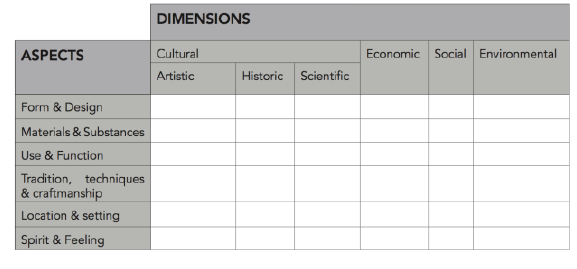
Figure 7. The proposed Hanghzou